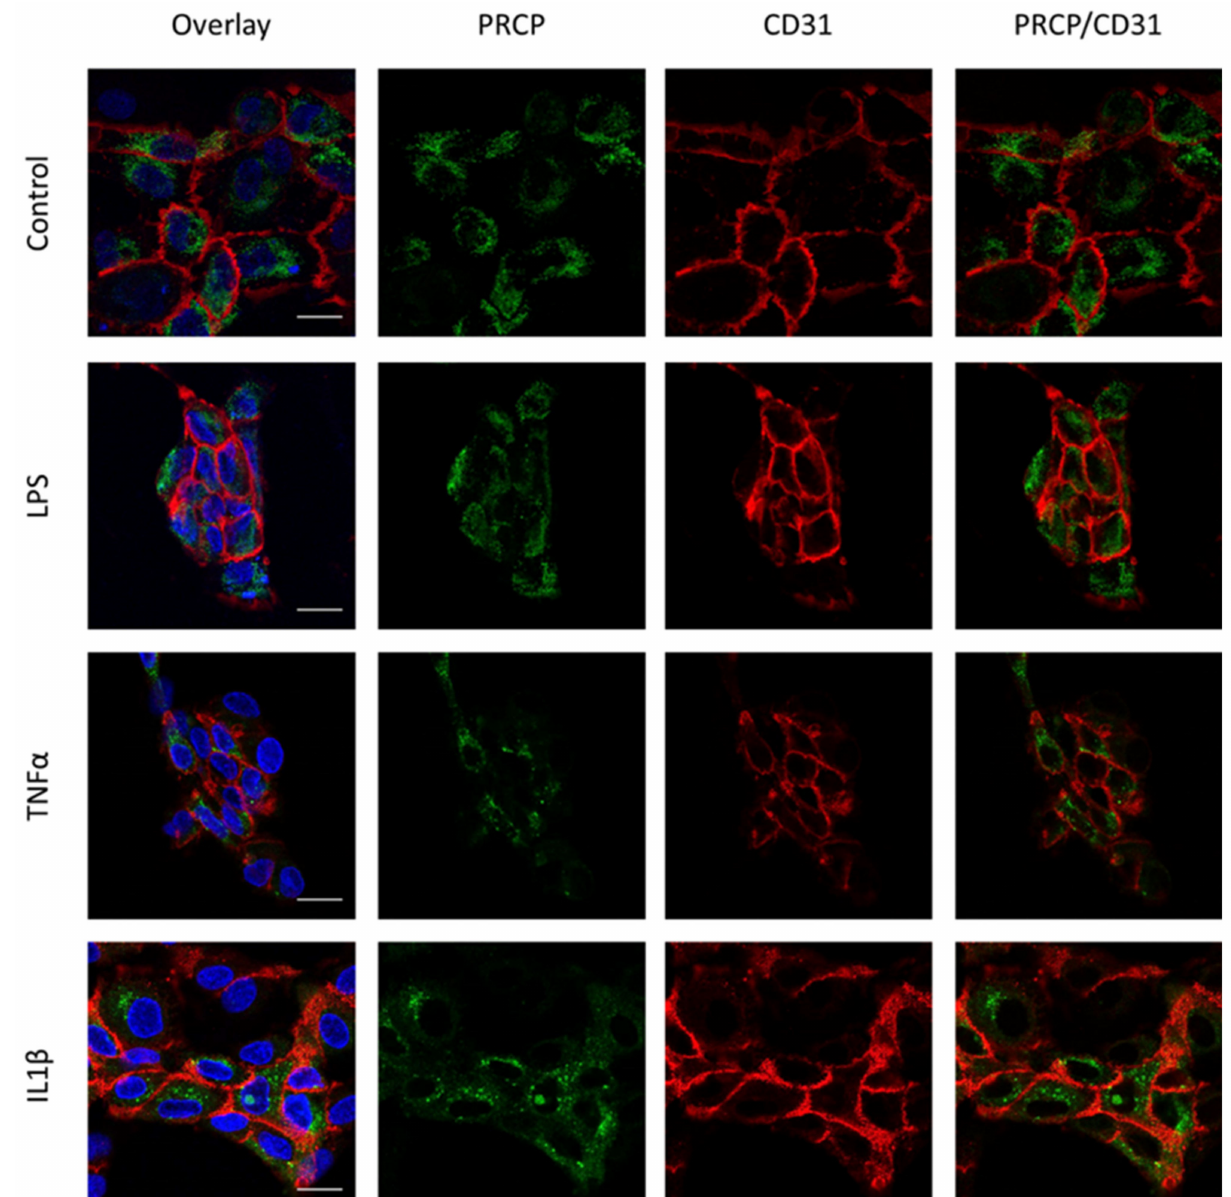
Figure 5. Overlap between PRCP and CD31 is not observed in HAoEC. Double staining of PRCP and CD31 in control, LPS-, TNF α -, and IL-1 β -stimulated permeabilized HAoEC. Cells were incubated for 16 h with the different stimuli, fixed with 4% PFA, permeabilized with 0.1% Triton X-100 and stained for PRCP (green), CD31 (red), and DAPI (nuclear marker, blue). Representative images of three independent experiments. Non-permeabilized cells showed comparable results. (bar = 20 µ